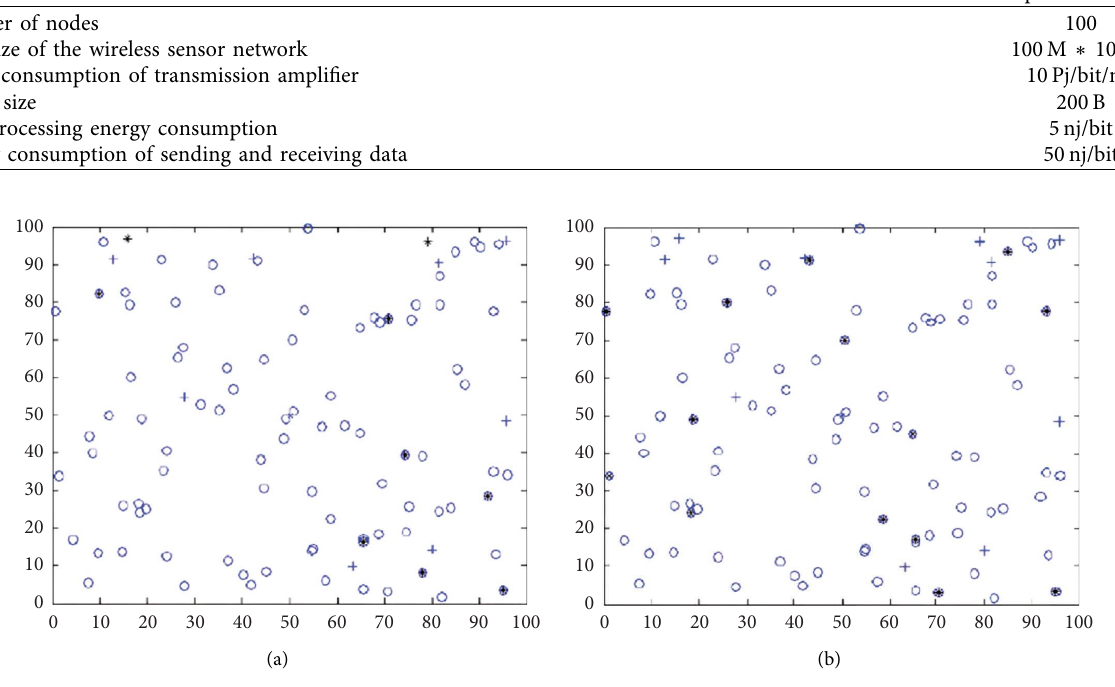
Figure 7: Cluster head election process of LEACH and LHTCA algorithms. (a) LEACH cluster head selection process. (b) LHTCA cluster head selection process.